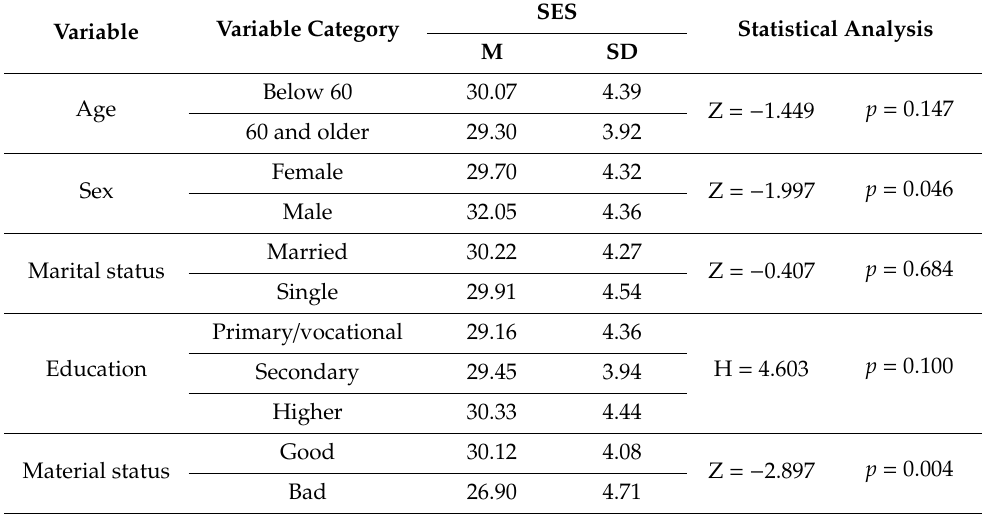
Table 2. Respondents’ self-esteem.